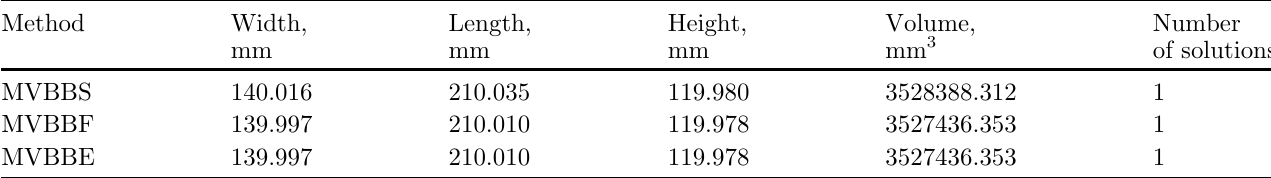
Table 2. The computation results of the MVBBS, MVBBF, MVBBE methods for the fi rst test.